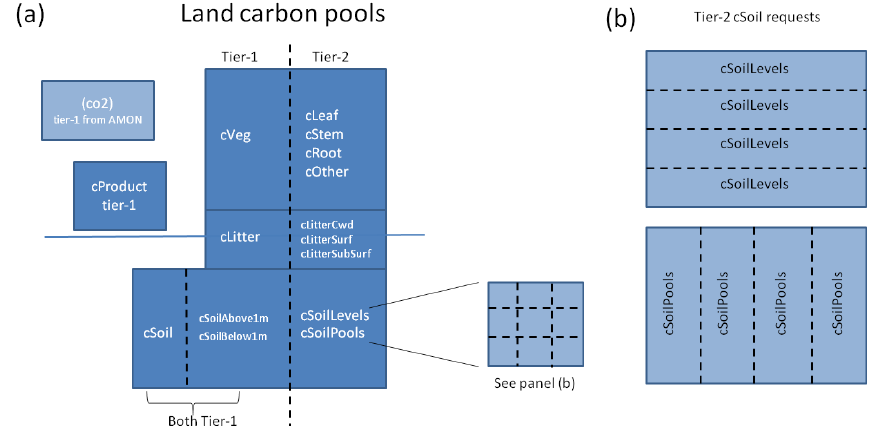
Figure 5. (a) Requested tier-1 and tier-2 variables representing land carbon pools. Although not a land carbon quantity, atmospheric CO 2 is shown here for completeness. (b) Detailed view of the tier-2 breakdown for soil carbon by vertical level (cSoilLevels) and by soil carbon pool